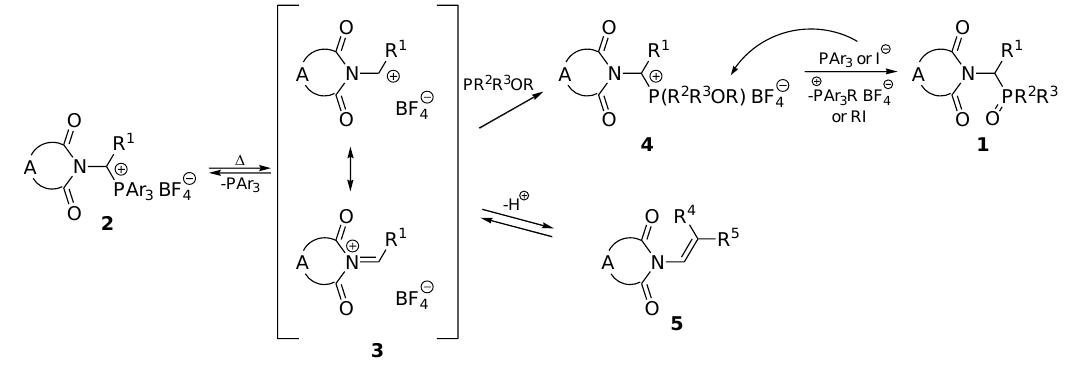
Table 1. Synthesis of 1-imidoalkylphosphonates, 1-imidoalkylphosphinates, and 1-imidoalkylphosphine oxides — conditions and